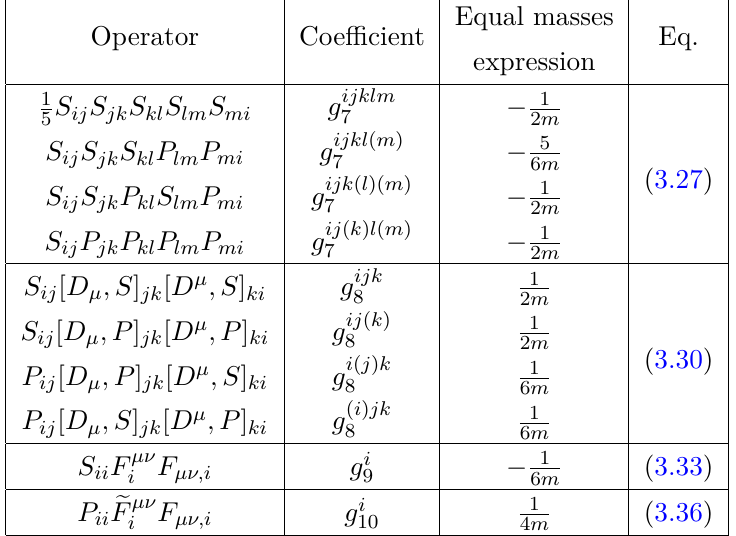
Table 2 . Values of the dimension-5 fermionic universal coefficients in the limit of equal